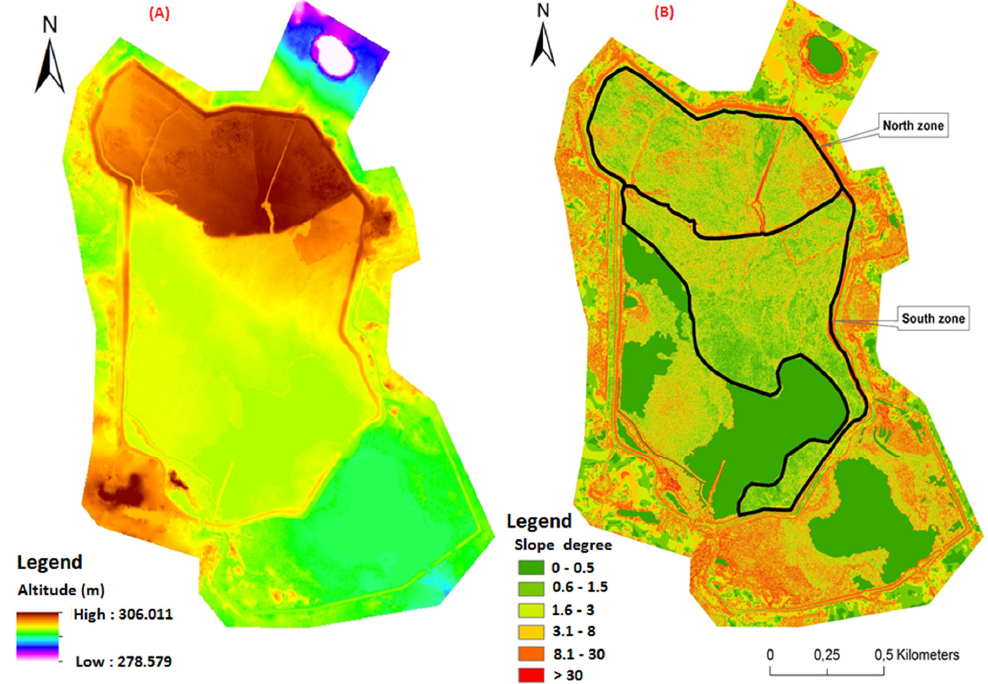
Figure 7. ( A ) Digital elevation model and ( B ) slope map within the Joutel